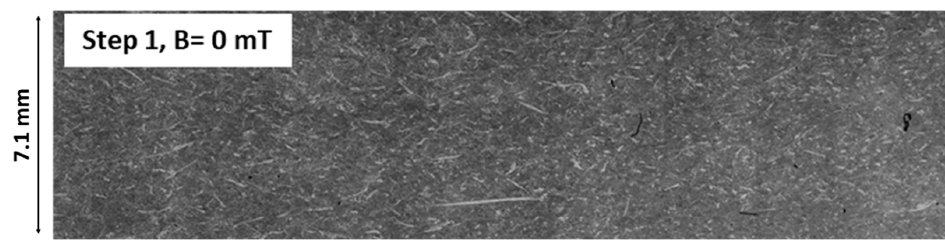
Figure 4. Micrograph of the solidified samples during step 1 (M = 50 ×